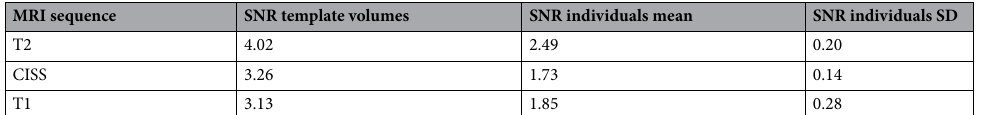
Table 1. Signal-to-noise ratios (SNR) in multivariate MRI templates are on average 1.7 times higher than in individuals’ volumes, resulting in improved visibility of structural details. Rendering can be performed nearly free of noise (cf. Fig. 1), and fine-grained structures like the separation of cochlear scalae become visible in templates that are sometimes not even clearly discernible in individual volumes (cf. Fig. 1, panel e).